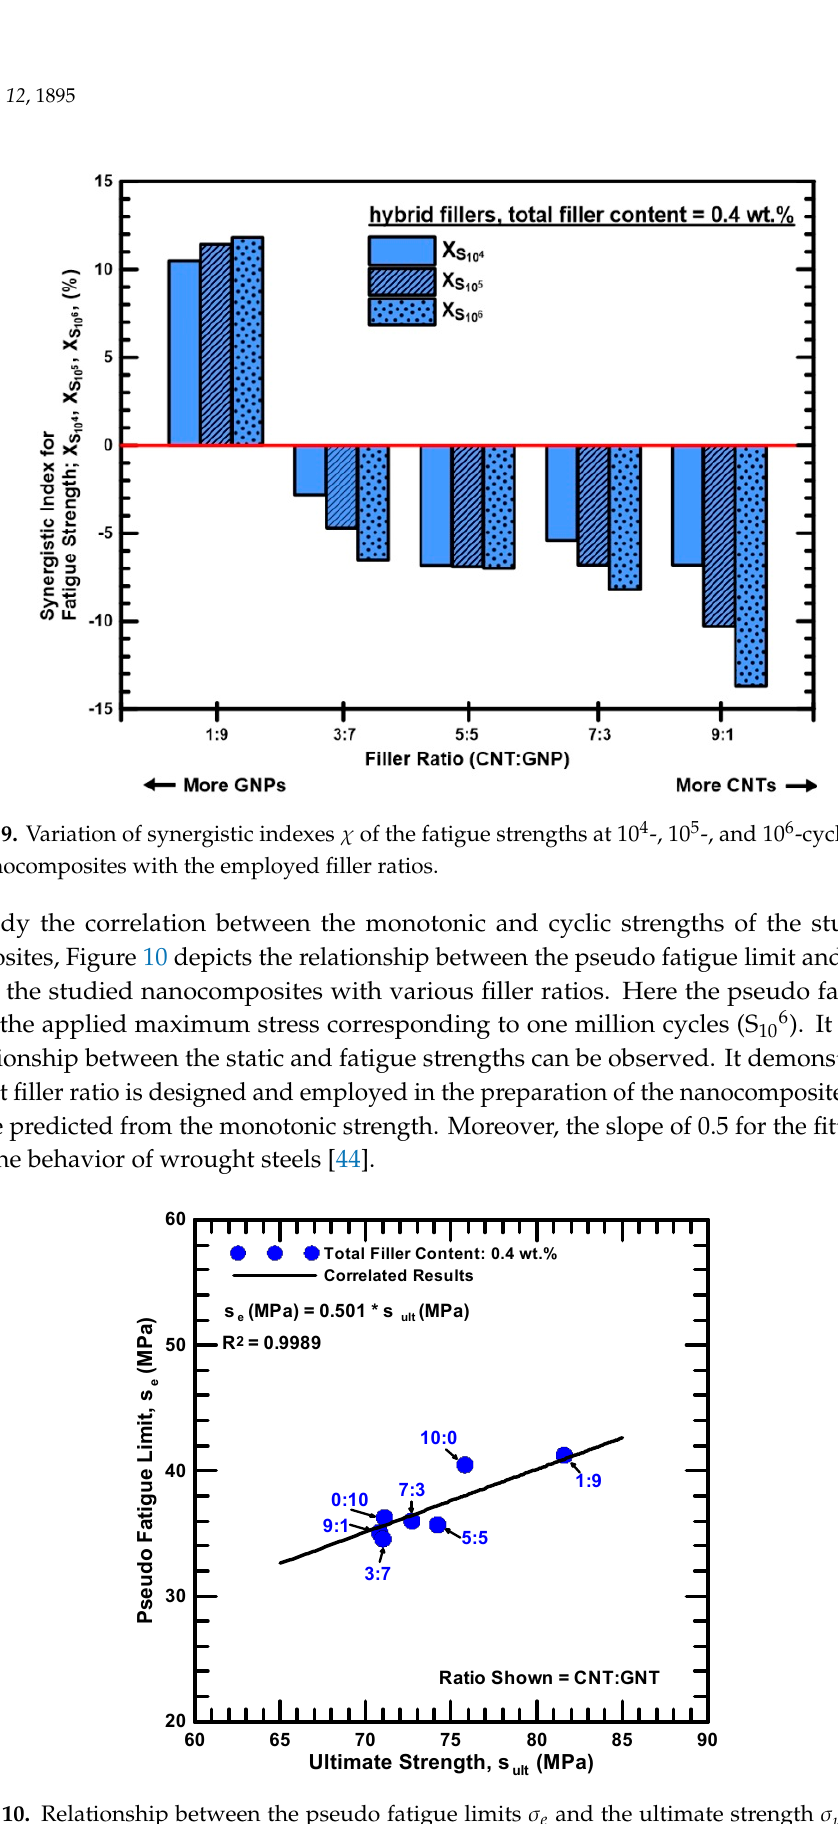
Figure 8. ( a ) S-N curves for the nanocomposites with various filler ratios, and ( b ) variations of fatigue strengths corresponding to various fatigue lives with filler ratios.